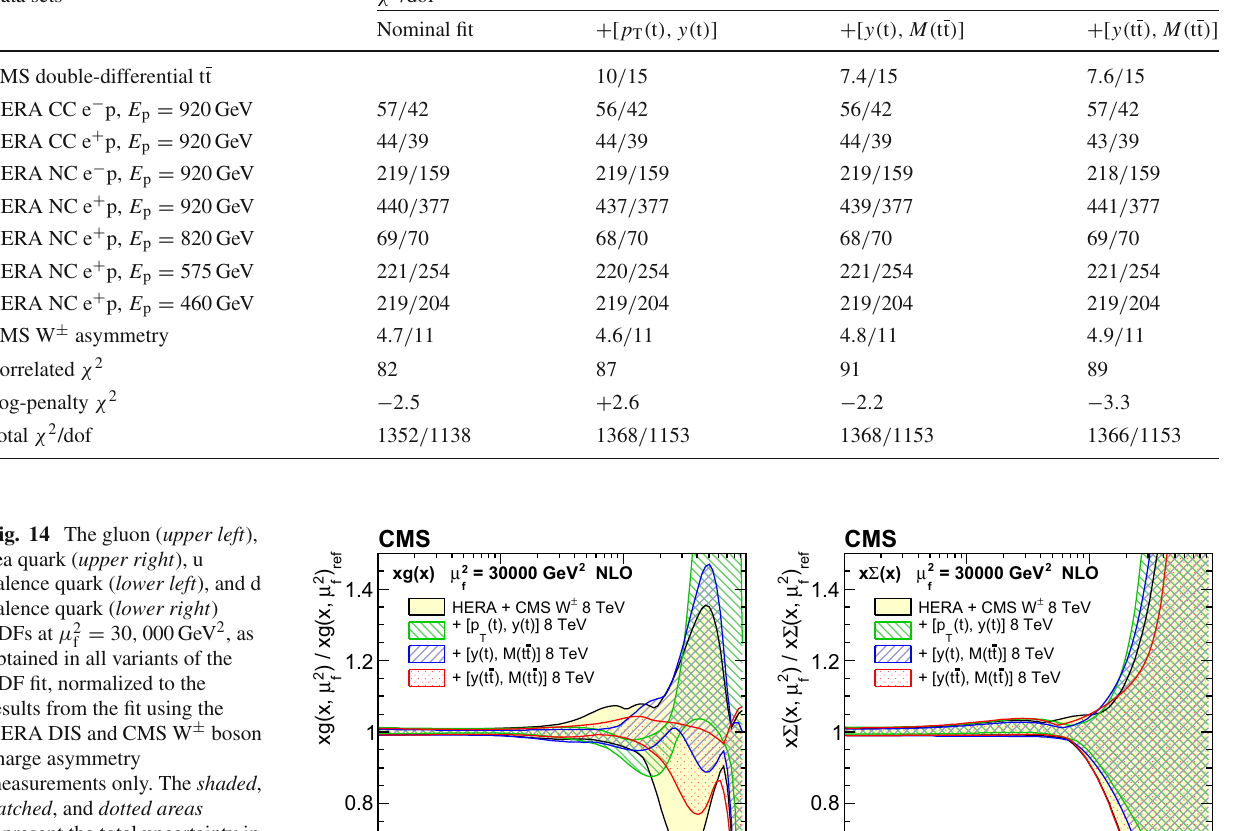
Table4 Theglobalandpartial χ 2 /dof valuesforallvariantsofthePDF fit. The variant of the fit that uses the DIS and W ± boson charge asym- metry data only is denoted as ‘Nominal fit’. Each double-differential tt cross section is added ( + ) to the nominal data, one at a time. For the HERA measurements, the energy of the proton beam, E p , is listed for Data sets